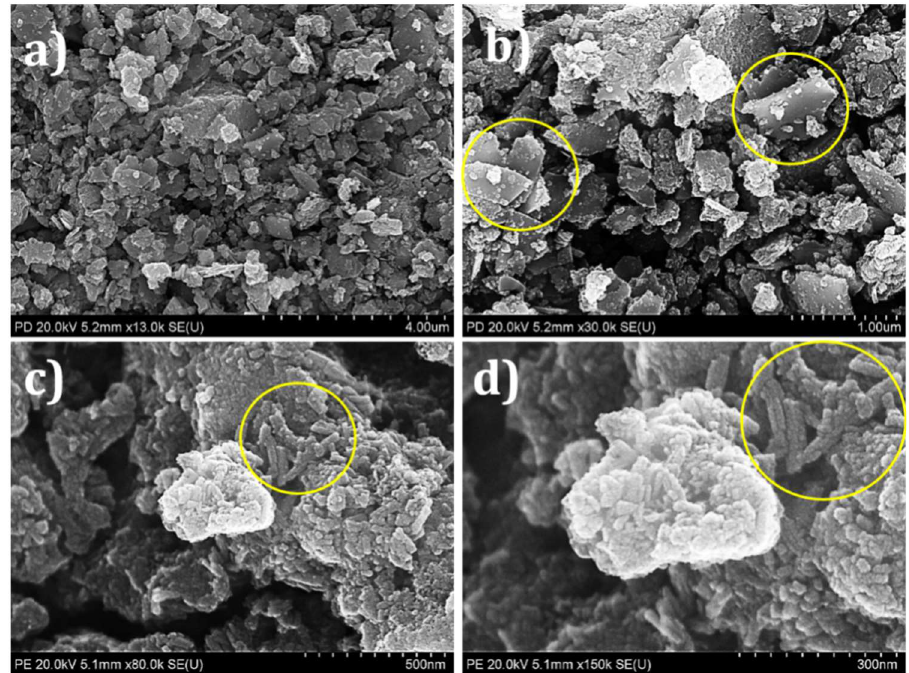
Figure 4. SEM micrographs of CTS NPs at various magnifications i.e., ( a ) 4.0 µm, ( b ) 1.0 µm with yellow circles indicating nanoparticles formation, ( c ) 500 nm with yellow circle indicating spherical nanostructures, and ( d ) 300 nm with yellow circle indicating agglomeration of oval-like spherical-shaped NPs with white spongy clusters.